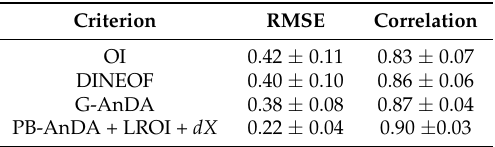
Table 3. Interpolation performance for the OSTIA SST case-study: mean root mean square error (RMSE) and correlation coefficients with the OSTIA SST for OI, DINEOF, G-AnDA and PS-MS-AnDA methods. We refer the reader to the main text for the details on the considered